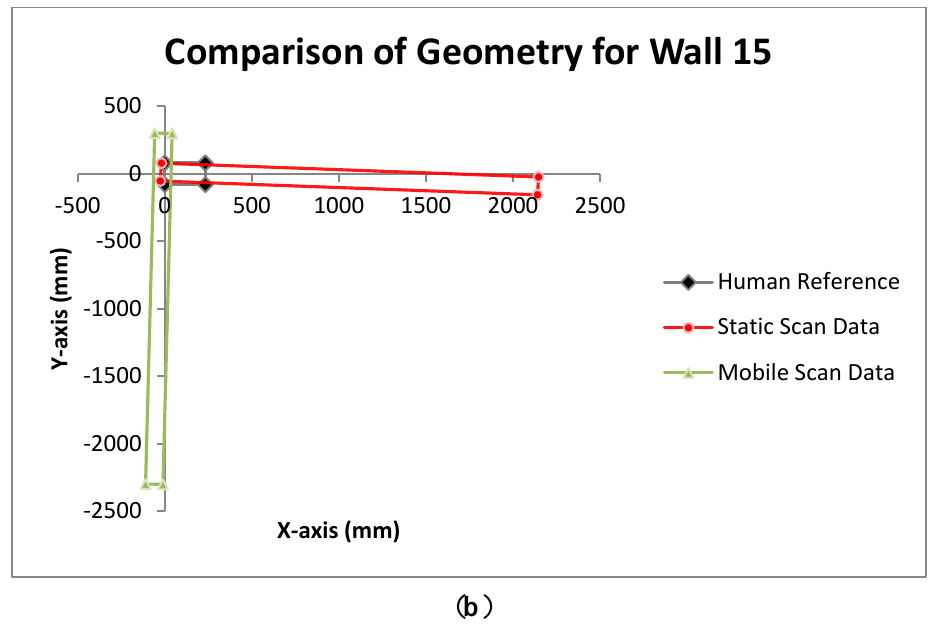
Figure 7. Plots of boundary placement of manual and automatically created geometry from the static scan data for ( a ) wall 4 and ( b ) wall 15 of the corridor